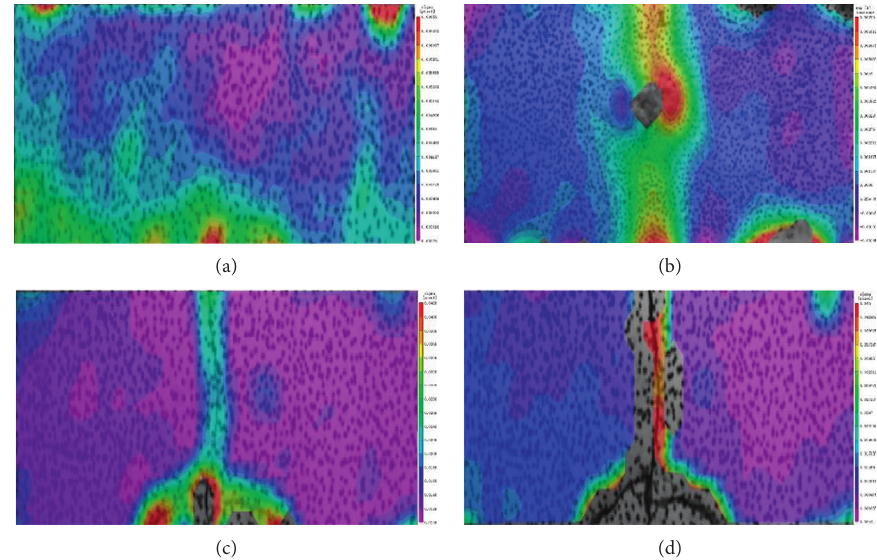
Figure 11: Strain cloud diagrams of failure process of normal concrete